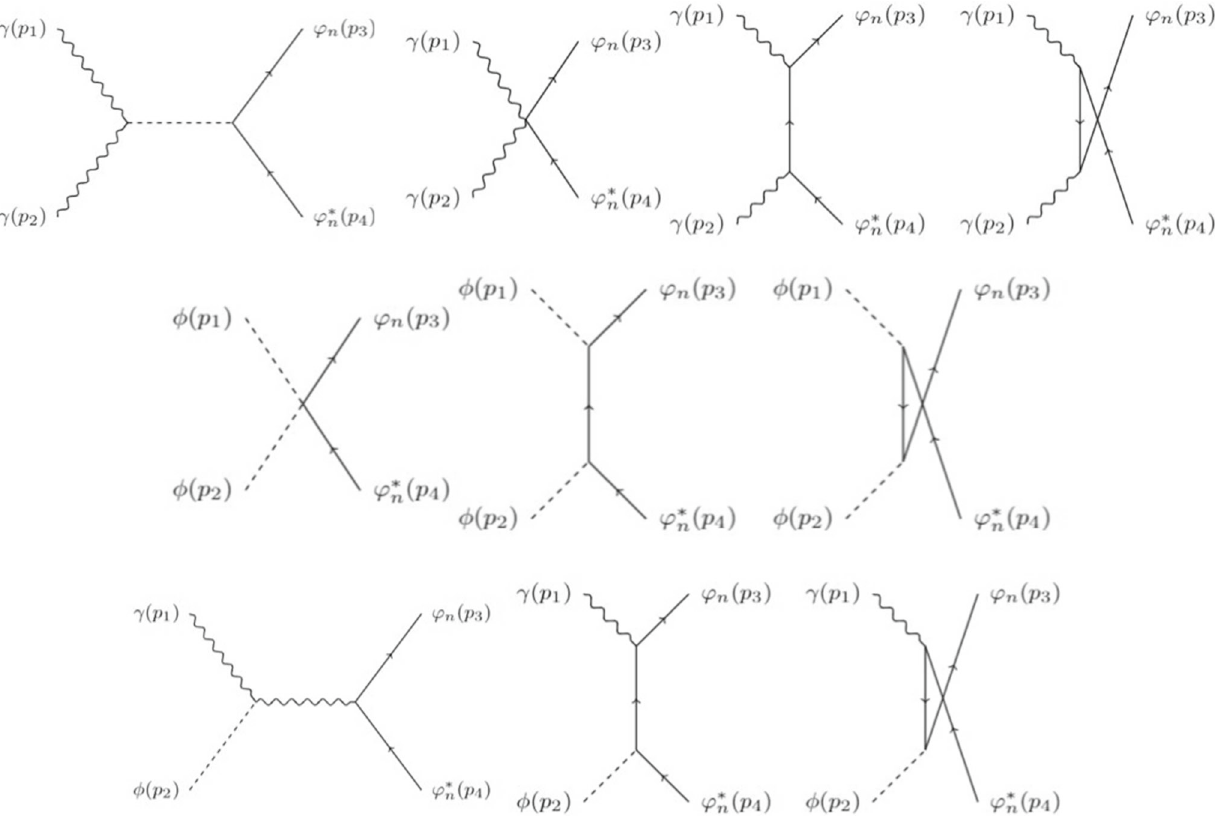
Fig. 1 Feynman diagrams for the non-gravitational production of a pair of matter states ϕ n ,ϕ ∗ n from two photons (first line), two dilatons (second line) and a dilaton and a photon (third